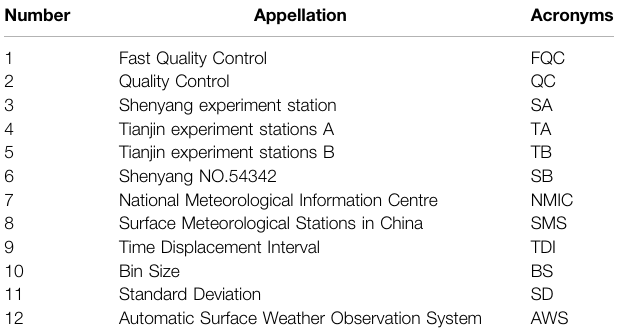
TABLE A1 | THE LIST OF